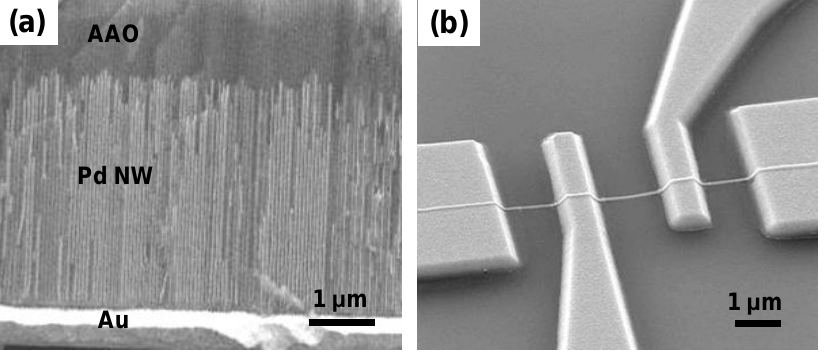
Figure 10. (a) Pd nanowire arrays grown by electrodeposition into nanochannels of AAO templates. (b) A representative four terminal device on an individual Pd nanowire. Data reproduced from Jeon et al .